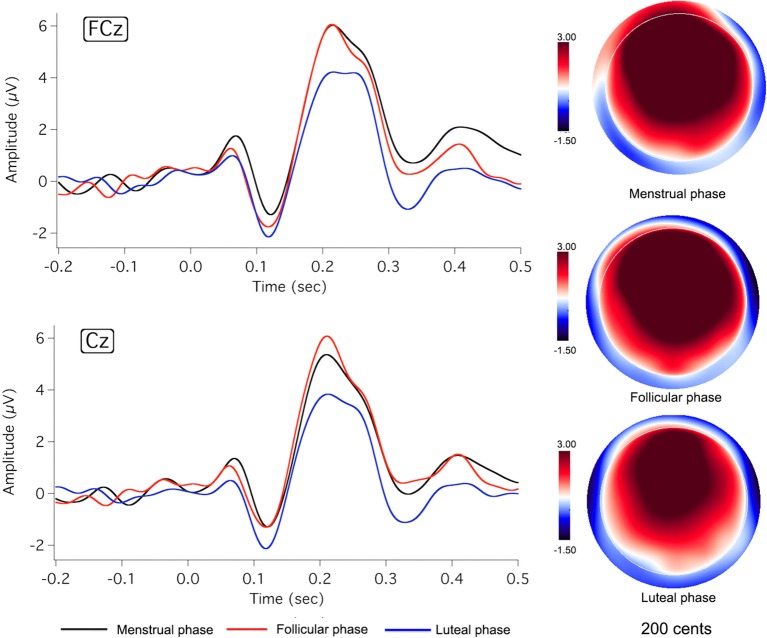
Grand-averaged ERP waveforms (left) in response to pitch-shift stimuli of −200 cents during the menstrual (black lines), follicular (red lines), and luteal phases (blue lines), and topographic distributions of P2 amplitudes (right) during the menstrual (top: latency = 218 ms), follicular (middle: latency = 223 ms), and luteal phases (bottom: latency = 221 ms).